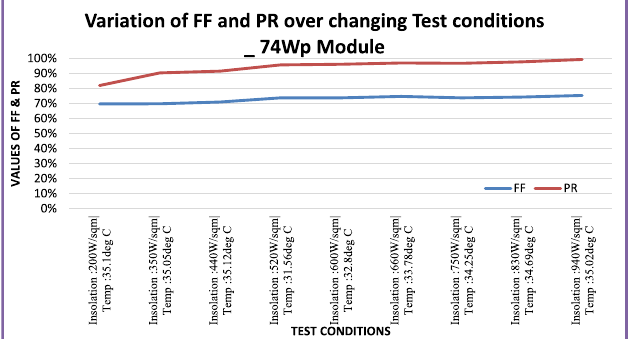
Fig. 7. FF and PR variation with varying insolation for 320 Wp